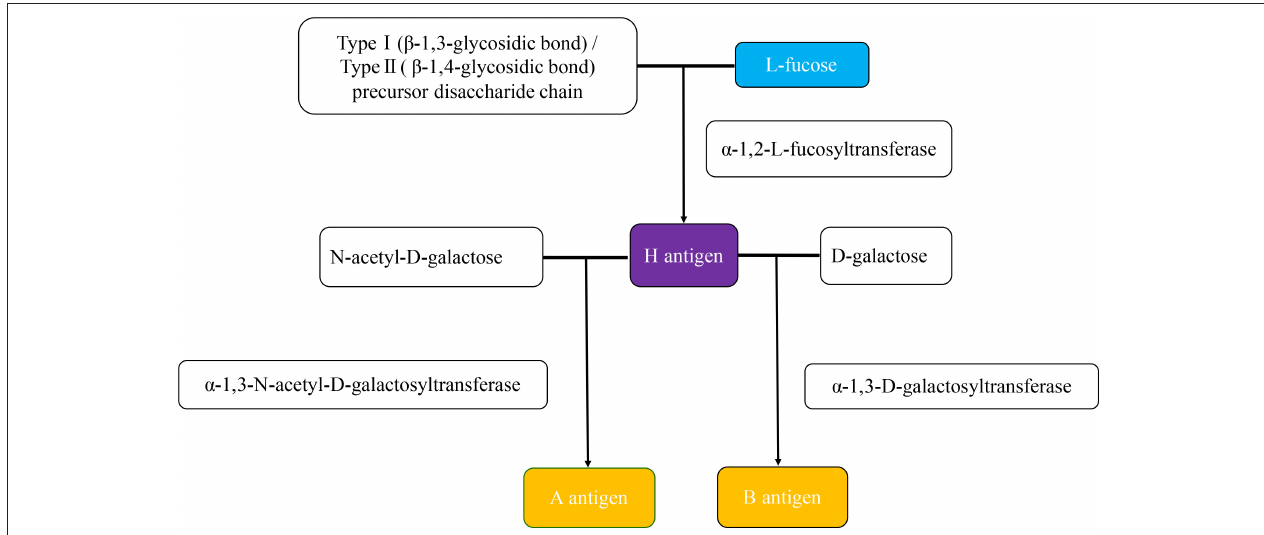
FIGURE 1 | The production of ABH antigens. The H antigen is produced when an α -1,2-L-fucosyltransferase catalyzes an L-fucose transfer to the precursor disaccharide chain of type 1 (soluble) or type 2 (cell-bound). The difference between type 1 and type 2 precursor disaccharide chains is that the residue terminal disaccharides are linked to different glycosidic chains. Type 1 is the β -1,3-glycosidic bond, and type 2 is the β -1,4-glycosidic bond. The H antigen is the precursor of both the A and B antigens. The N-acetyl-D-galactose for A antigen, D-galactose for the B antigen. The actions of α -1,3-N-acetyl-D-galactosyltransferase and α -1,3-D-galactosyltransferase are responsible for forming the A and B antigens,